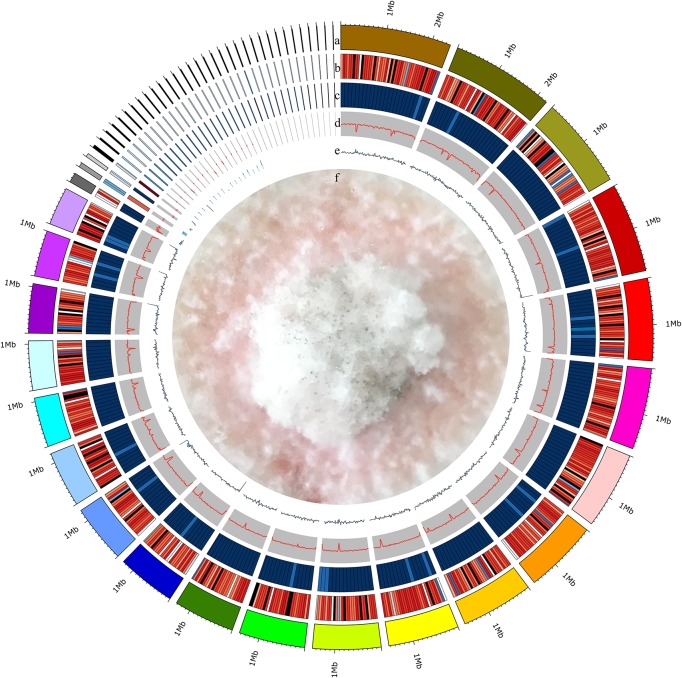
Circular representation of the Shiraia bambusicola genome. The following data are shown (from outer to inner): (a) Genome; sorted by length. (b) Gene density; gene number in 50,000 bp non-overlapping windows. (c) ncRNA density; ncRNA number in 100,000 bp non-overlapping windows. (d) GC; GC rate in 20,000 bp non-overlapping windows. (e) GC skew; GC skew in 20,000 bp non-overlapping windows. (f) The mycelia of Shiraia bambusicola S4201.